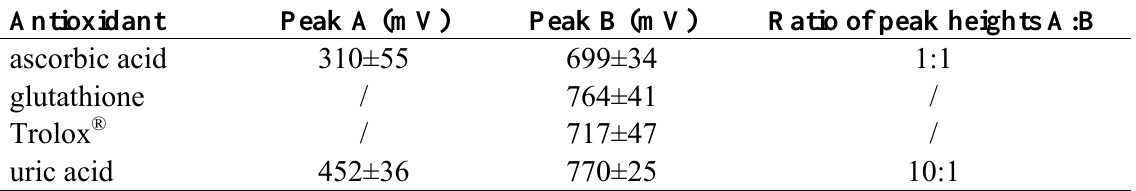
Table 1. Peaks observed by SWV for antioxidant standards of ascorbic acid, glutathione, trolox and uric